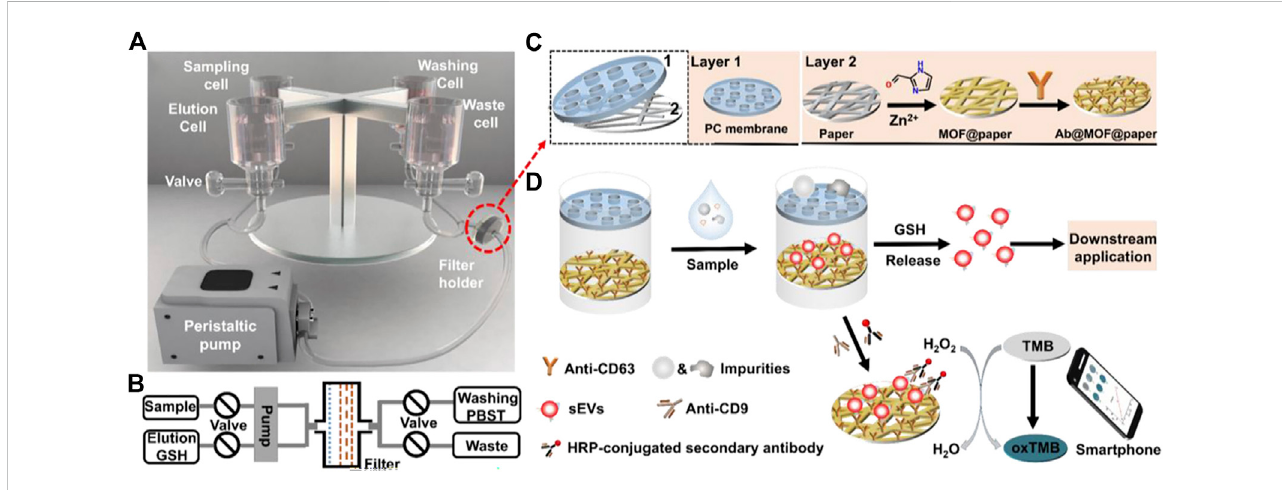
FIGURE 8 SchematicofthesEV-IsoPD. (A) Thedevice consistsofaperistalticpump,four-cellcontainer, valves,and fi lterholder. (B) Schematicdiagramofthe fl ow system ofsEV-IsoPD. (C) SchemeofthePC membraneandthefabricationofAb@MOF@paper. (D) The process ofcapturing,releasing,and detecting sEVs by sEV-IsoPD. Reproduced with permission from (Seo et al.,